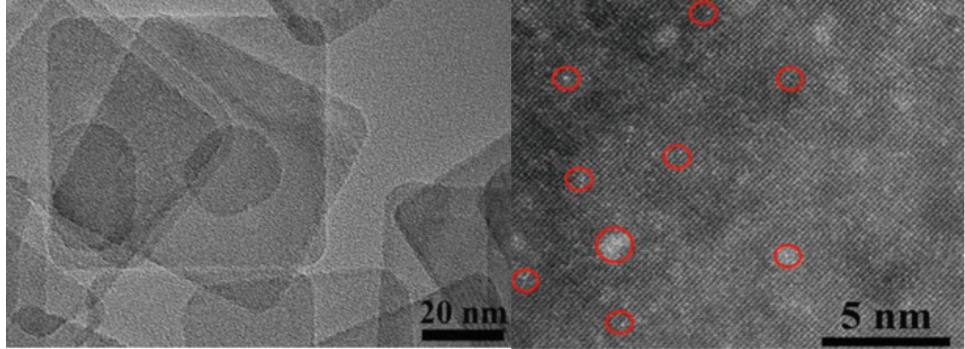
Figure 5. TEM image of Cu-TiO 2 photocatalyst [96]. The red circles in the diagram indicate the atomically dispersed Cu.